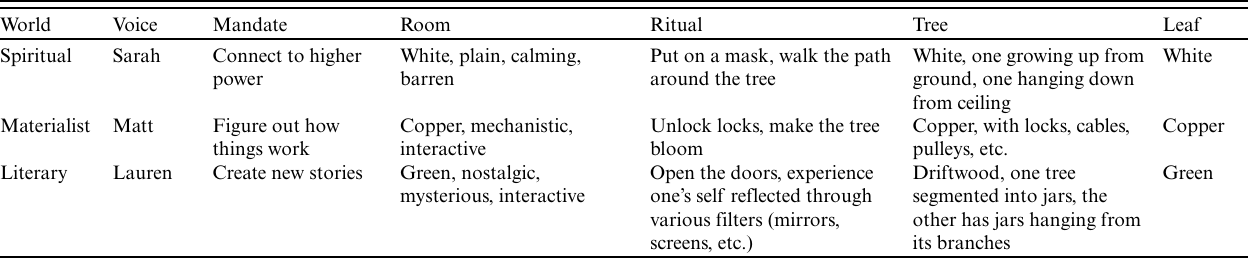
Table 1 . Main characteristics of the three worlds. World